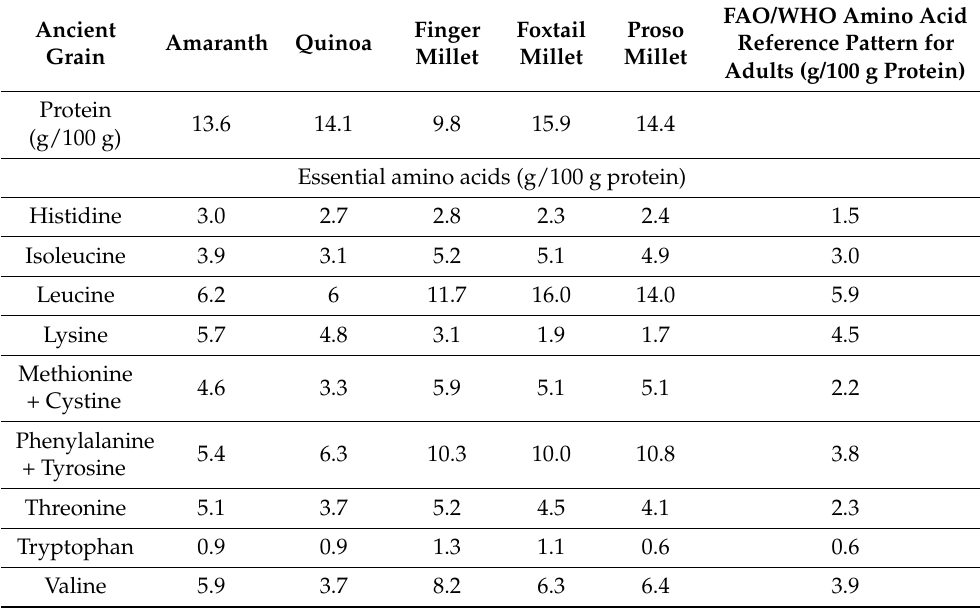
Table 1. Protein and amino acid profile of ancient